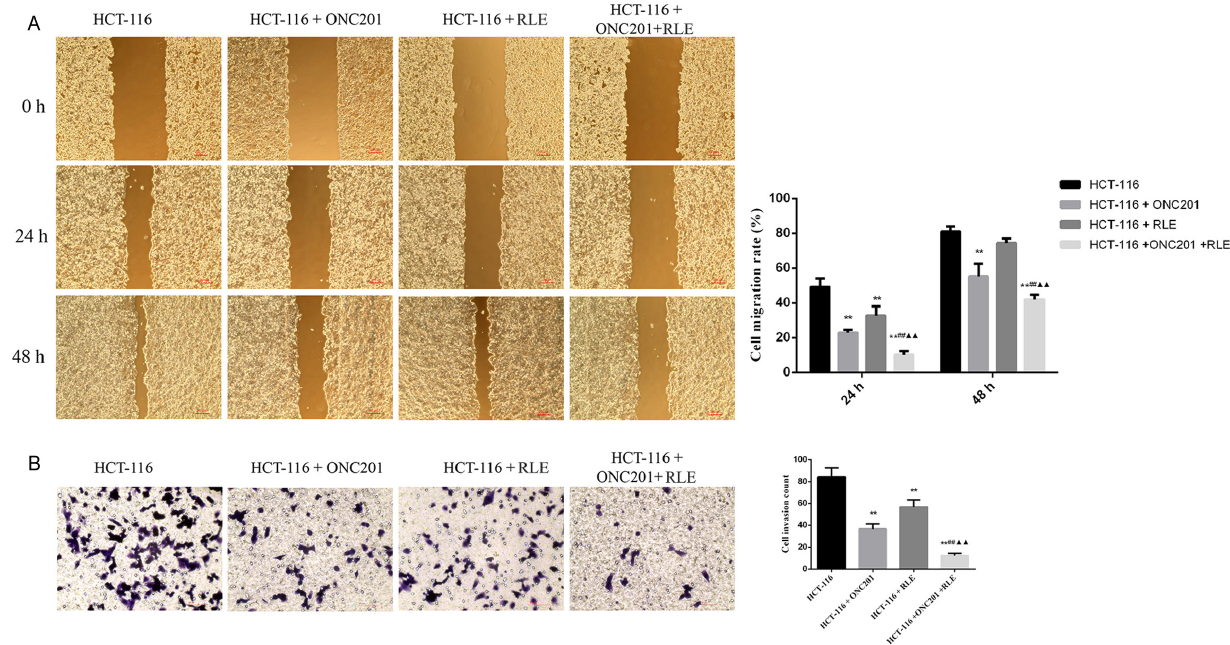
Figure 3. RLE and ONC201 co-treatment inhibited HCT116 cell migration and invasion. (A) Wound healing assays were performed to detect cell migration. (B) Transwell assays were performed to detect cell invasion. * P < .05, ** P < .01 versus the HCT116 group; # P < .05, ## P < .01 versus the HCT116 + ONC201 group; ▲ P < .05, ▲▲ P < .01 versus the HCT116 + RLE group. RLE, raw lacquer